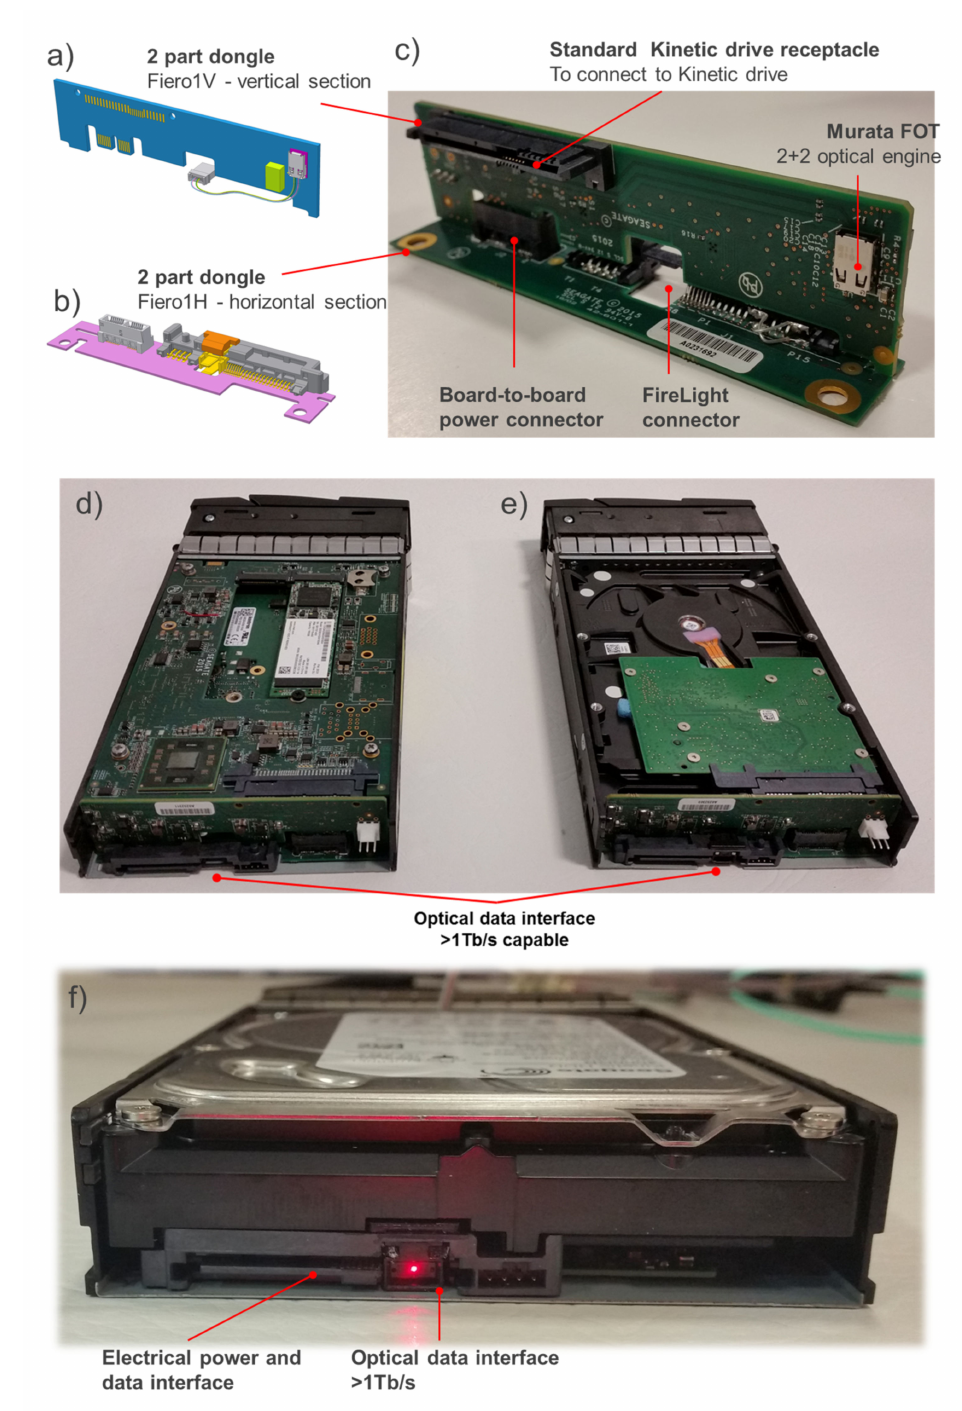
Figure 13. Optical end node connector and interface with proprietary optical end node connector assembled onto a hard disk drive, ( a ) CAD view of vertical interface cards, ( b ) CAD view of horizontal interface card, ( c ) photo of vertical and horizontal interface cards connected, ( d ) microserver end node with optical interface, ( e ) data storage end node with optical interface, ( f ) Ethernet disk drive with proprietary electro-optical